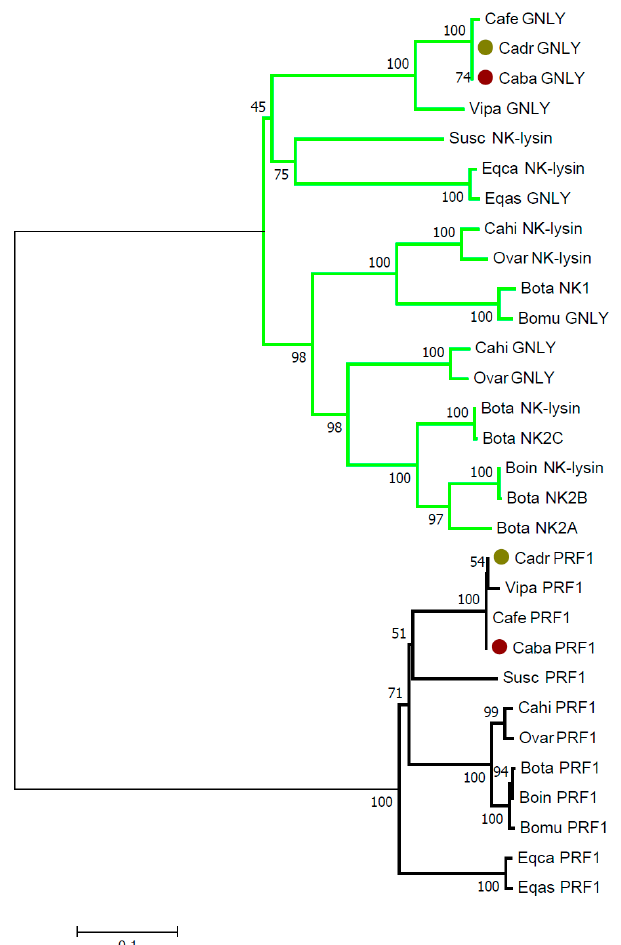
Figure 2. Phylogeny of pore-forming proteins in domesticated ungulates. Amino acid sequences for perforin (PRF1) and granulysin (GNLY)/ NK-lysin of dromedary (Cadr) and Bactrian camel (Caba), highlighted by color dots, were compared to reference sequences of wild camel (Cafe), alpaca (Vipa), swine (Susc), goat (Cahi), sheep (Ovar), cattle (Bota), zebu cattle (Boin), wild yak (Bomu), horse (Eqca), and donkey (Eqas) (for accession numbers see Table S2 and KT715031 for bovine NK-lysins NK1, NK2A, NK2B, and NK2C), and analyzed in MEGA X. The evolutionary history was inferred by the Neighbor-Joining method and the evolutionary distances were computed using the p-distance method and are given in the units of amino acid differences per site. The percentages of concordant replicates in the bootstrap test (1000 replicates) are shown next to the branches. Bold—pore-forming protein for eukaryotic membranes; green—pore-forming proteins for prokaryotic (mitochondrial) membranes.